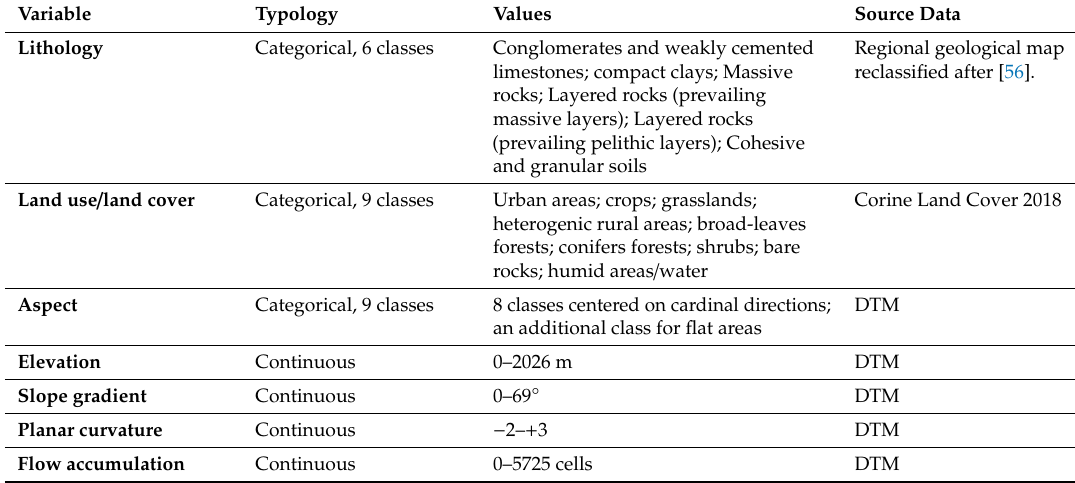
Table 1. Explanatory variables used in the base configuration of the susceptibility